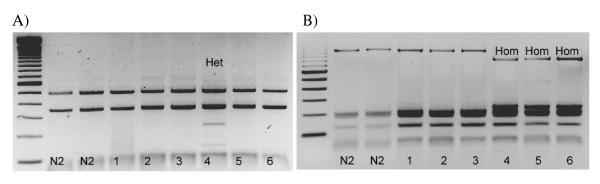
Restriction enzyme digests of DNA from heterozygous and homozygous mutants. A) CAPS analysis of sibling lines for CN646 htp-3(vc1) using the restriction enzyme Taq1. The lanes labelled N2 are wildtype controls. Lane marked 4 exhibits additional bands when digested with this enzyme indicating this line is heterozygous for the vc1 mutation. B) CAPS analysis of sibling lines for CN711 mdf-2(vc15), using the restriction enzyme Hinf1. The lanes labelled N2 are wildtype controls. Lanes marked 4, 5 and 6 show additional cleavage bands and are missing the wildtype band indicating that they are homozygous for the vc15 mutation.